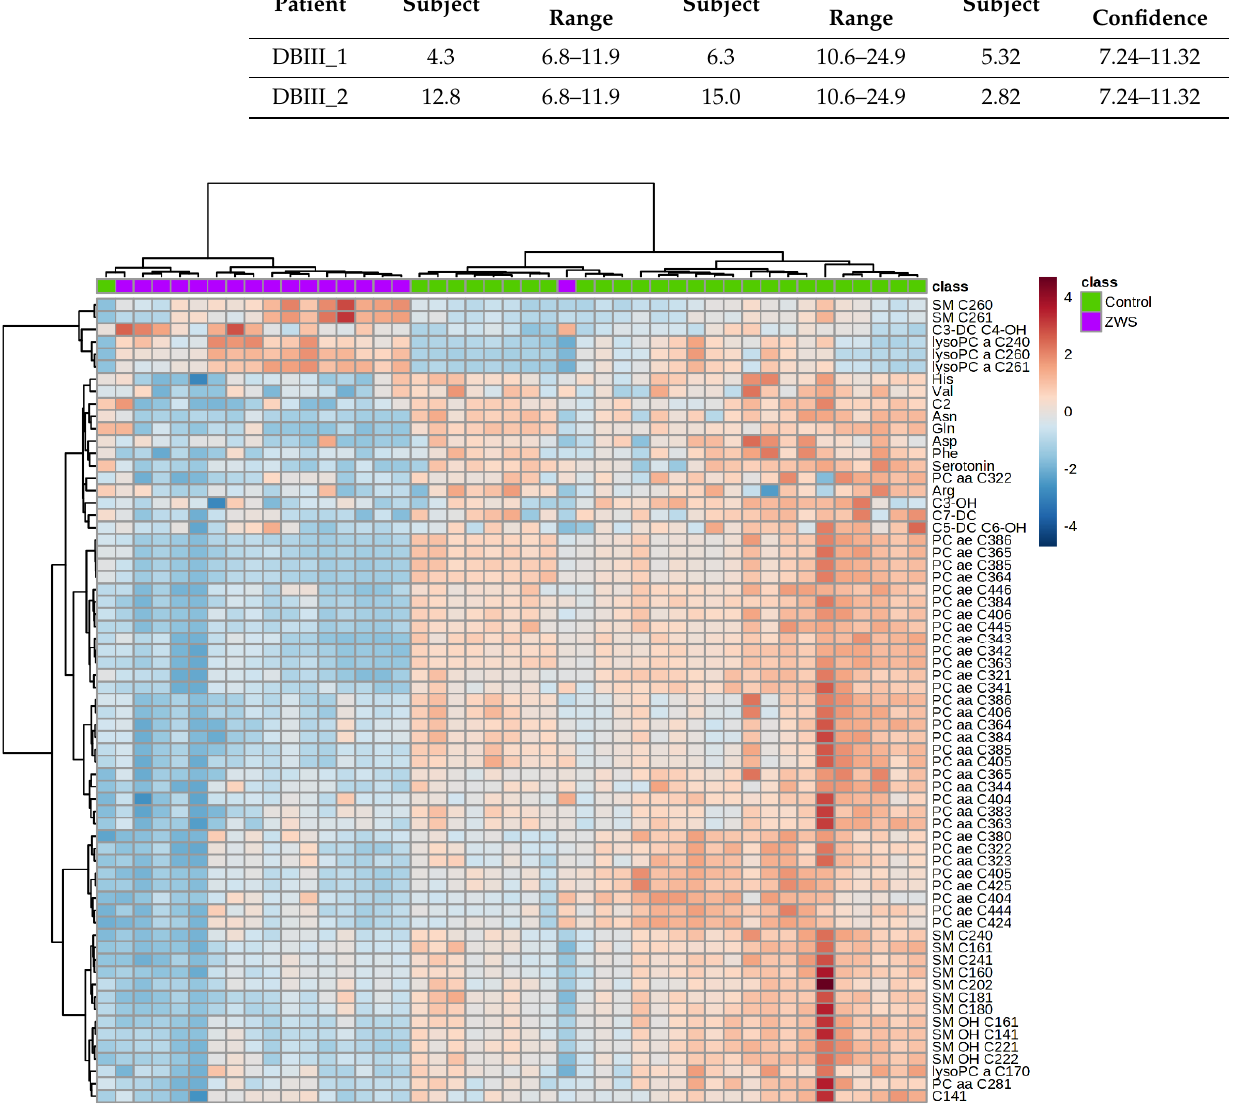
Figure A1. Heatmap illustrating clustering of Zellweger syndrome spectrum patients (ZSS) and controls. Serum from patients analyzed using the Biocrates AbsoluteIDQ p180 kit. Only the 65 components with highest p -value by Student’s t -test are shown. Euclidean distance and Ward clustering were used. Normalized data was used and colormaps were auto scaled. n = 28 (Controls), 17 (ZSS/ PEX1 ). C: Acyl-Carnitine; lysoPC: lysophosphatidylcholine; PC aa: phosphatidylcholines with 2 acyl-linkages; PC ae: phosphatidylcholine with one acyl and one ether linkage; SM: sphingomyelin.